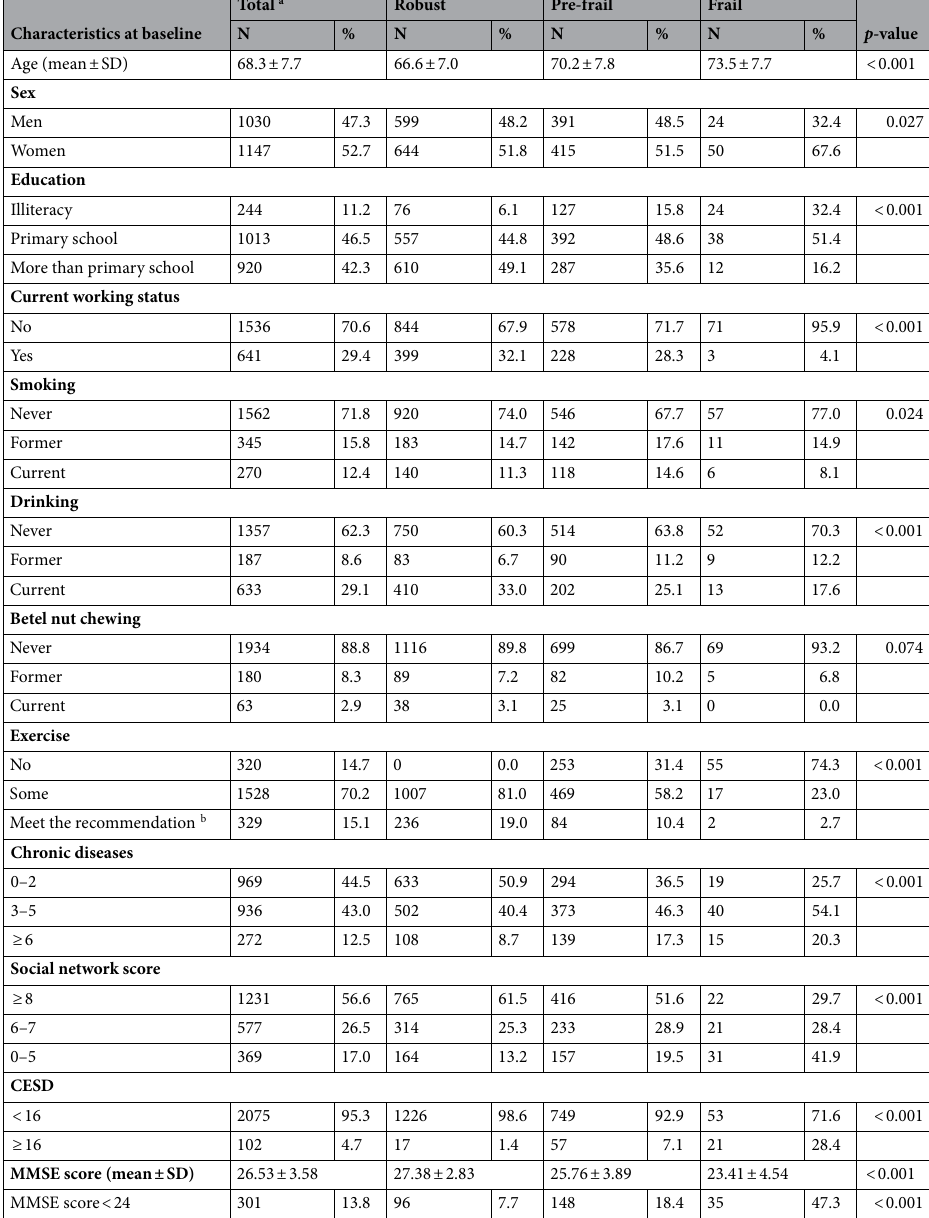
Table 1. Baseline characteristics of the study population. CES-D center for epidemiologic studies-depression scale, MMSE mini-mental status examination, N population size, SD standard deviation. a A total of 54 participants (2.5%) were missing physical frailty status. b Moderate exercise for 150 min per week or vigorous exercise for 75 min per